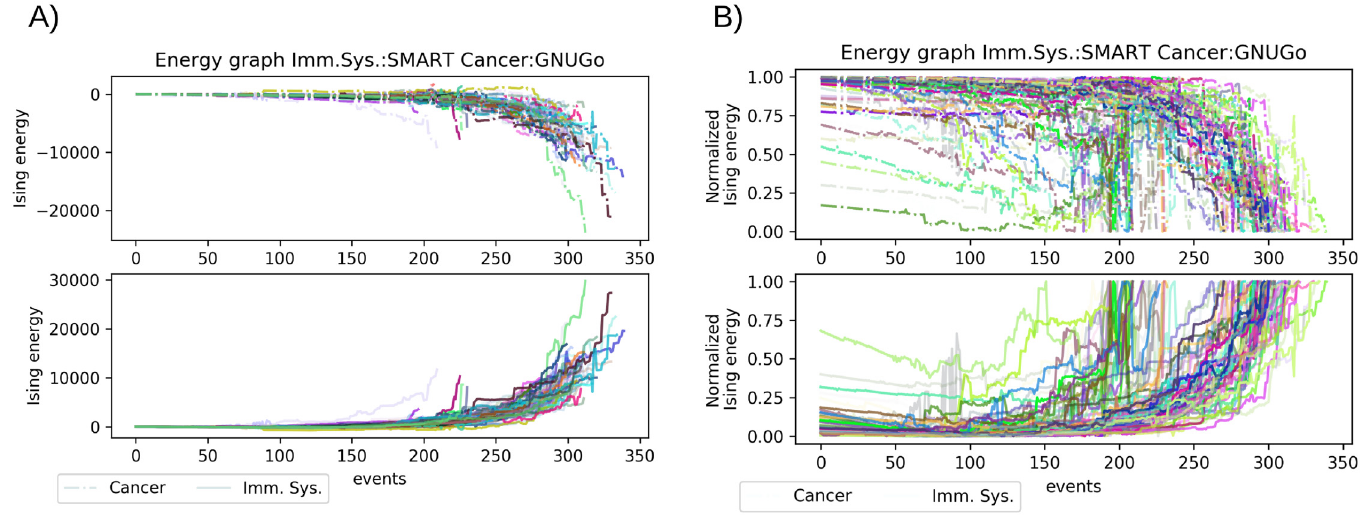
Fig 4. Comparison of the aggressive player vs. good player scenario. A) Plot of the Ising energy for all the simulations between GNUGo and SMART, upper panel corresponds to cancer cells energy lower panel correspond to immune system energy. B) Normalized values of the simulations in the same order as A.